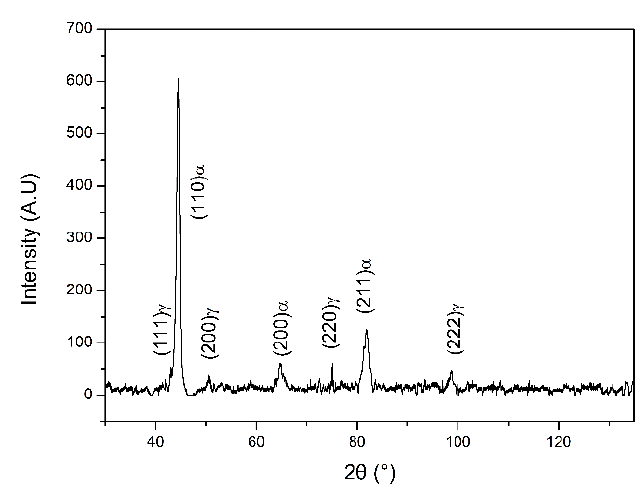
Figure 7. XRD pattern of sample of partitioning for 30 s.